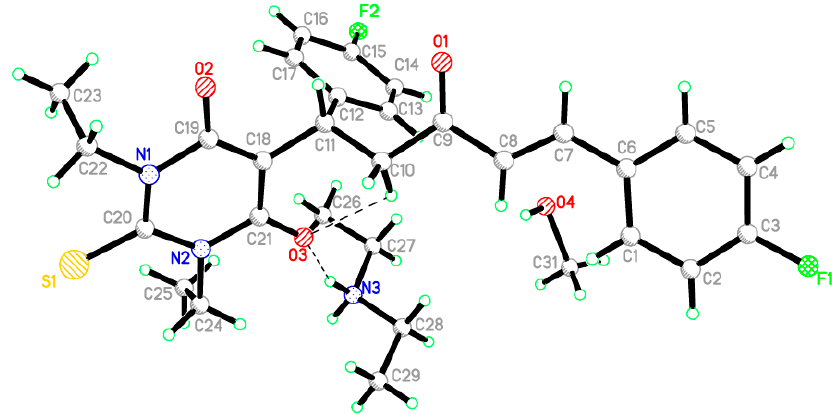
Figure 1. The molecular structure of compound 3 showing 50% probability displacement ellipsoids for non-H atoms, Dotted lines indicate hydrogen bond interactions.